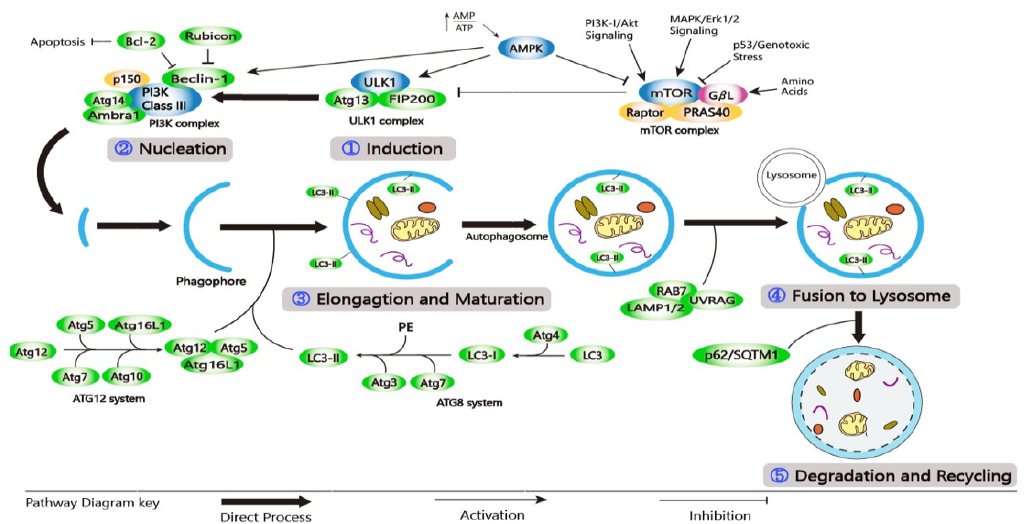
Figure 2. A schematic diagram of the molecular pathway of autophagy. ( 1 ) Induction; ( 2 ) Nucleation; ( 3 ) Elongation and Maturation; ( 4 ) Fusion to Lysosome; and ( 5 ) Degradation and Recycling.